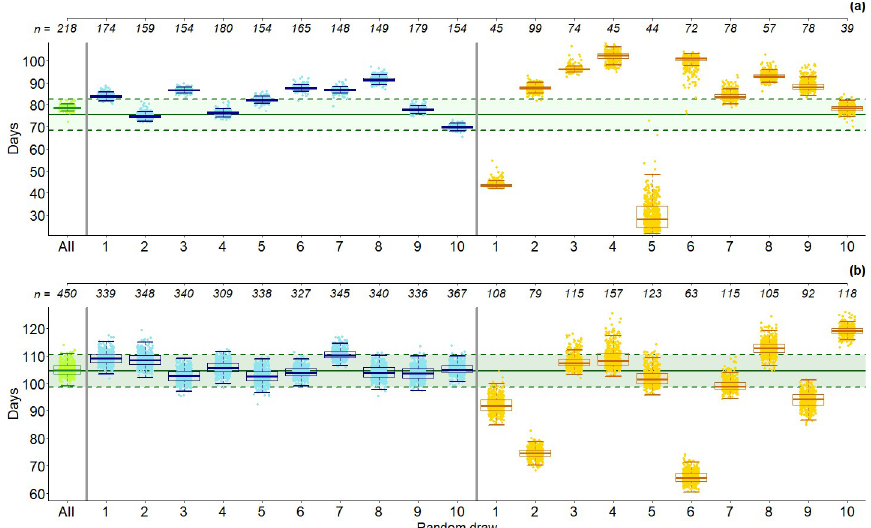
Fig 4. Estimated mean decay time of 10 datasets randomly selected from (a) Mohneke and Fruth [73] and (b) S4 [this study], using logistic regression [57]. Clouds of dots represent 500 mean decay times estimated via bootstrapping [38], with boxplots representing quartiles and variability of the bootstrap samples. From left to right: 1) full datasets (green) i.e. “All”; 10 random draws of 2) 75% of nest groups (blue); 3) 25% of nest groups (yellow). The upper x-axis shows the number of individual nests n in each draw. Green, horizontal lines show the reference decay value (mean, solid line) and 95% confidence intervals (dashed lines) for a) decay time for Mohneke and Fruth [73]; and b) S4 estimated via gamma survival model [this